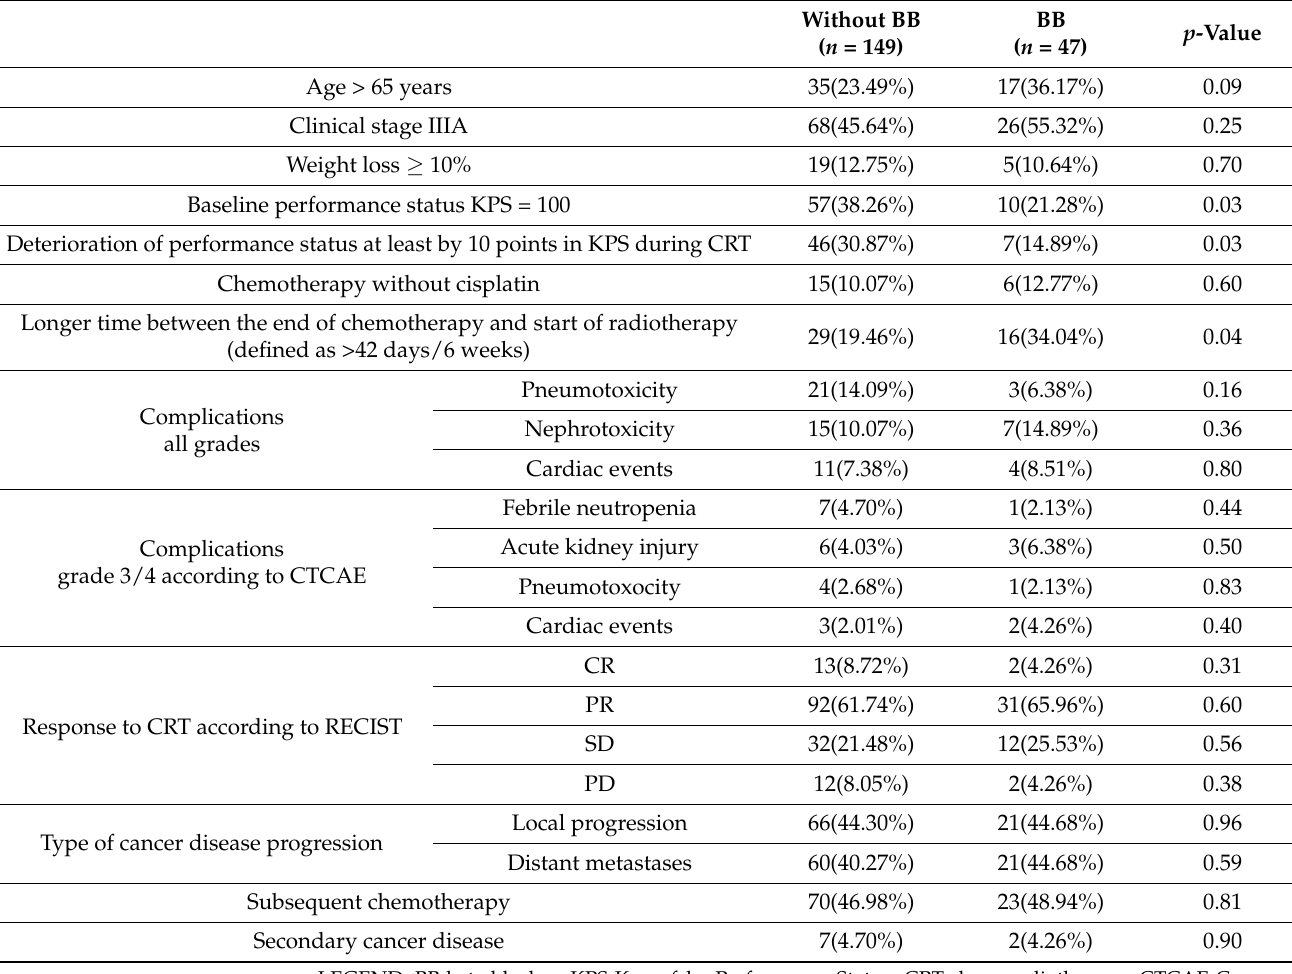
Table 2. The comparison between patients on beta-blockers and patients without such therapy.